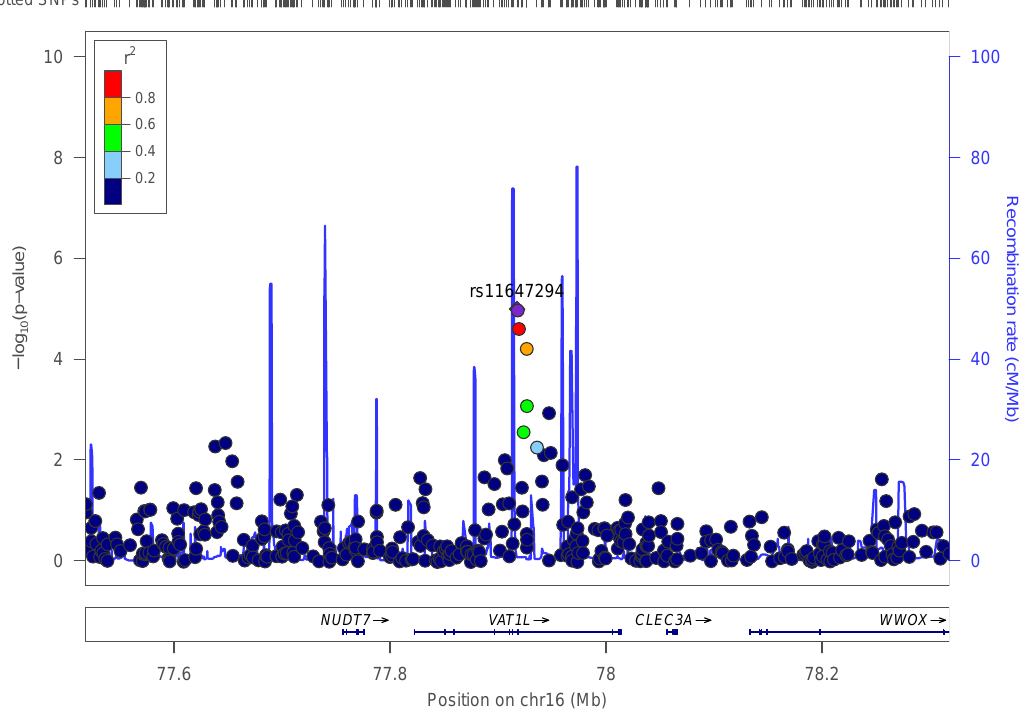
Figure 3. Regional plot for the SNP rs11647294, located in the vesicle amine transport 1 like ( VAT1L ) gene, on chromosome 11 in the GWAS, for adiponectin concentrations in the whole population. p -values obtained in the general linear regression model adjusted for sex, age, diabetes and BMI.